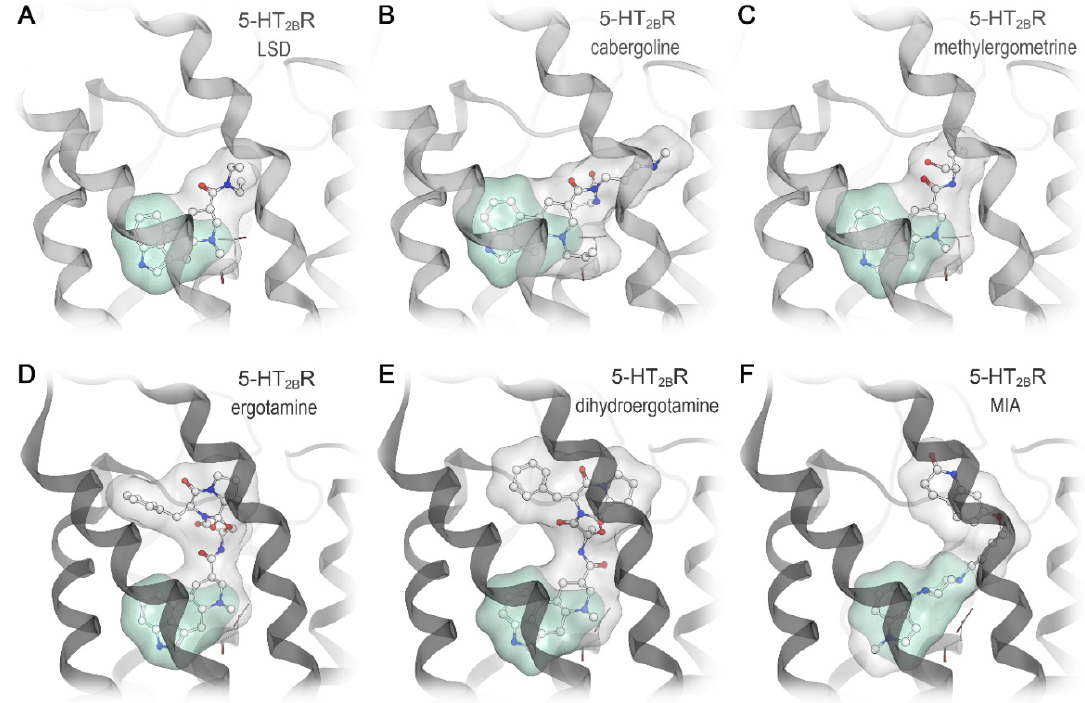
Figure 5. Extended binding modes are a common feature in biased 5-HT 2B R ligands. The upper row shows LSD in its co-crystallized conformation ( A , PDB entry: 5TVN [24]), and proposed binding modes of cabergoline ( B ) and methylergometrine ( C ) docked to the LSD-bound receptor state. The second row depicts the bitopic binding modes of ergotamine in its co-crystallized conformation ( D , PDB entry: 4IB4 [23]), and proposed binding modes of dihydroergotamine ( E ) and MIA ( F ) docked to the ergotamine-bound receptor state. While the green surfaces indicate the serotonin substructure, the grey surfaces illustrate the extended molecule parts pointing towards the extracellular loop region.